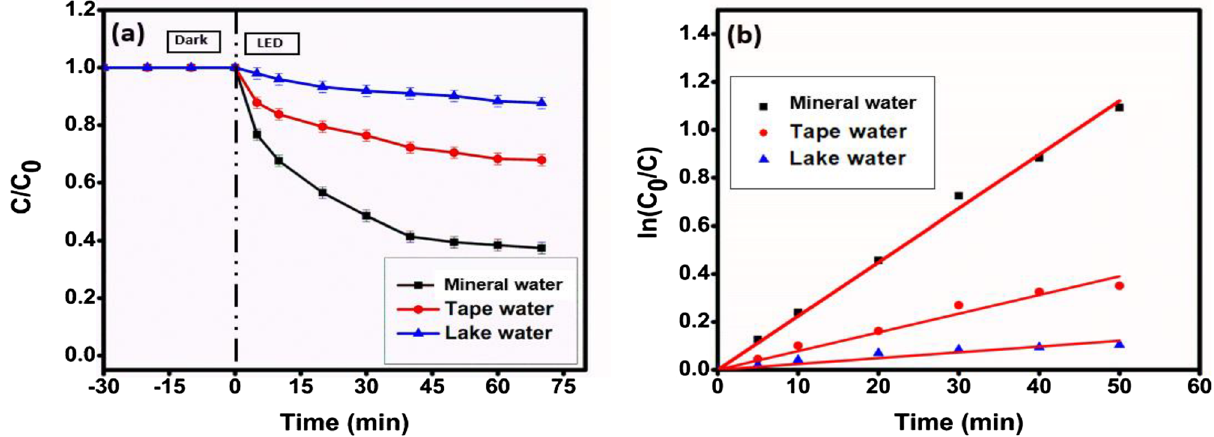
Figure 19. ( a ) Degradation profile and ( b ) kinetics plot for photodegradation of prepared MG dye solution in different water samples employing photocatalyst